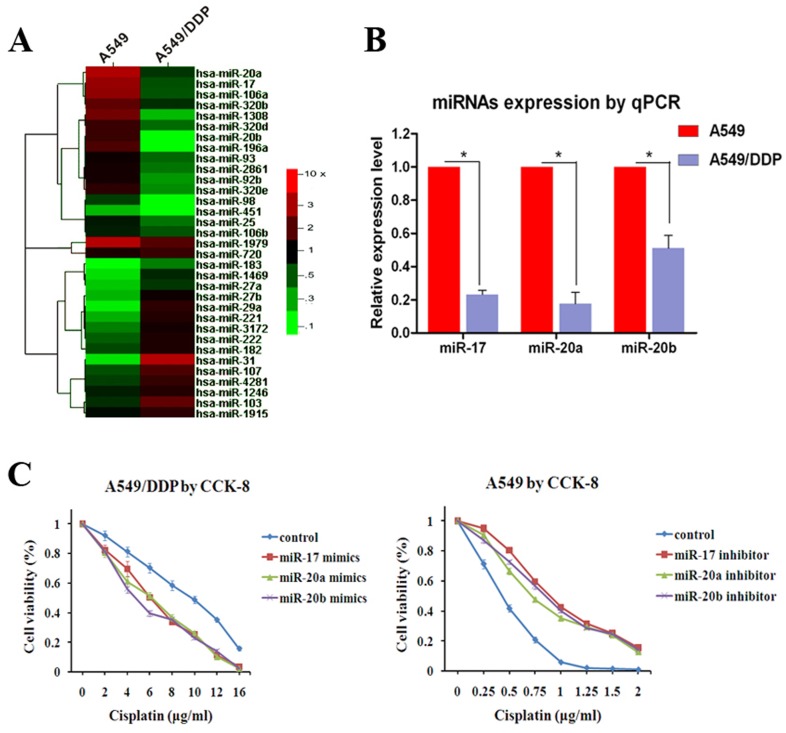
miR-17, 20a, 20b are low-expressed in A549/DDP cells and regulate cisplatin-resistant.(A) Clustering of cisplatin-resistant related miRNAs in A549 and A549/DDP cells. The vertical axis corresponds to the expression difference of miRNAs, A549 means A549 cells compared with A549/DDP cells in one microarray assay, A549/DDP means A549/DDP cells compared with A549 cells in another repeat microarray assay. The horizontal axis corresponds to miRNAs. miRNA expression levels were depicted as color variation from red (high expression) to green (low expression) according to color bar scale. (B) RT-PCR validated that miR-17, 20a, 20b expression levels were significantly lower in A549/DDP cells. (C) Over-expression or inhibition of miR-17, 20a, 20b significantly increased or decreased the growth-inhibitory effect of cisplatin in A549/DDP cells or A549 cells. *P<0.05. Results were representative of three experiments.